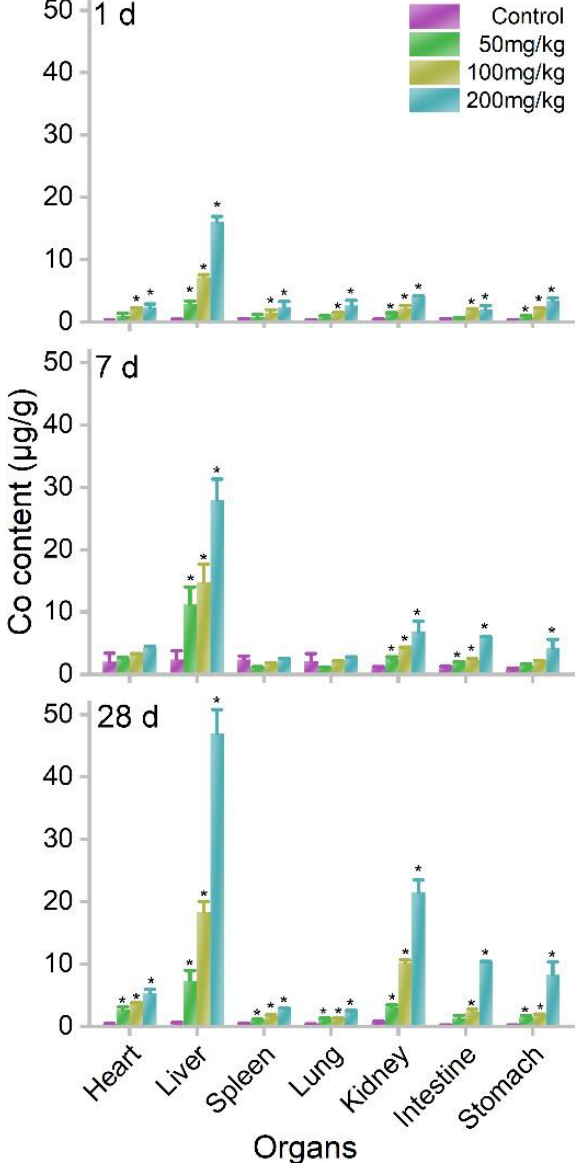
Figure 3. Co contents in organs after oral exposure to MOF-74(Co) NPs in mice at 1, 7, and 28 d ( n = 3). * p < 0.05 compared to the control group.